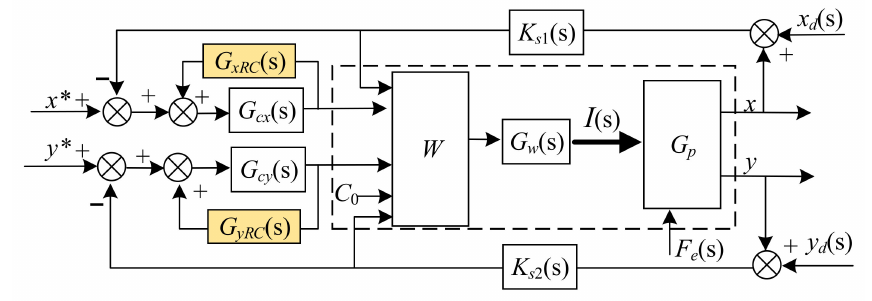
Figure 13. Control block diagram of the entire system with repetitive